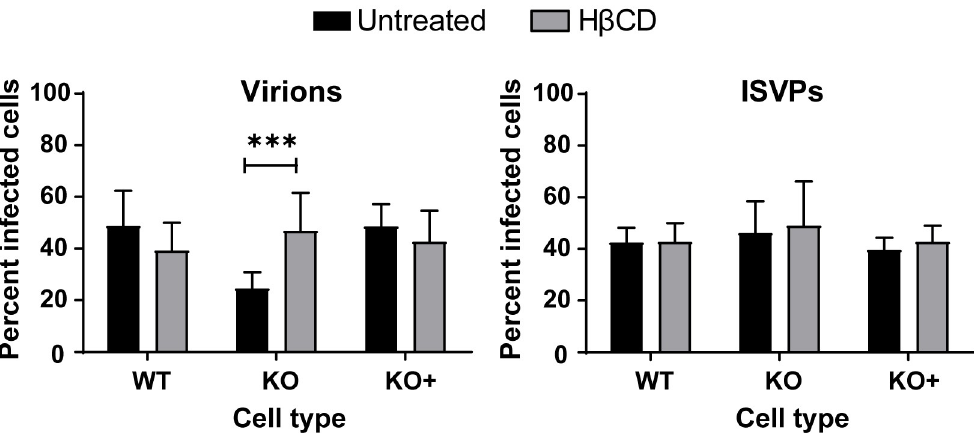
Fig 8. H β CD treatment restores reovirus infection of NPC1 KO HBMECs. WT, KO, and KO+ HBMECs were pretreated with 1 mM H β CD or PBS for 24 h, adsorbed with reovirus virions or ISVPs at MOIs of 10,000 or 100 particles/cell, respectively, and fixed at 18 h post-adsorption. The percentage of infected cells was determined by enumerating reovirus- infected cells following immunostaining with a reovirus-specific antiserum. The results are presented as the mean of three independent experiments. Error bars indicated standard deviation. ��� , P < 0.001 as determined by two-tailed unpaired t- test.